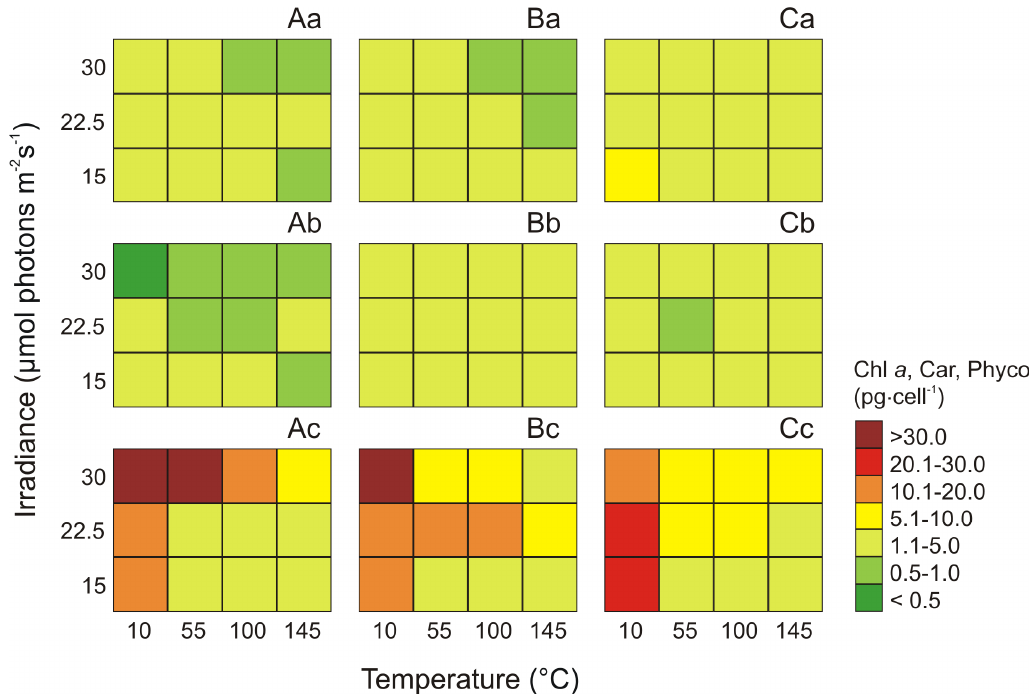
Figure 2. Changes in content (pg ∙ cell − 1 ) of Chl a ( a ), sum of total Car ( b ), and sum of total Phyco ( c ) obtained after 14 days of experiment for three phenotypes of Synechococcus sp.: Type 1 ( A ), Type 2 ( B ), Type 3a ( C ) under different irradiance ( μ mol photons m − 2 s − 1 ) and temperature (°C) conditions. Type 3a ( C ) under di ff erent irradiance ( µ mol photons m − 2 s − 1 ) and temperature ( ◦ C)